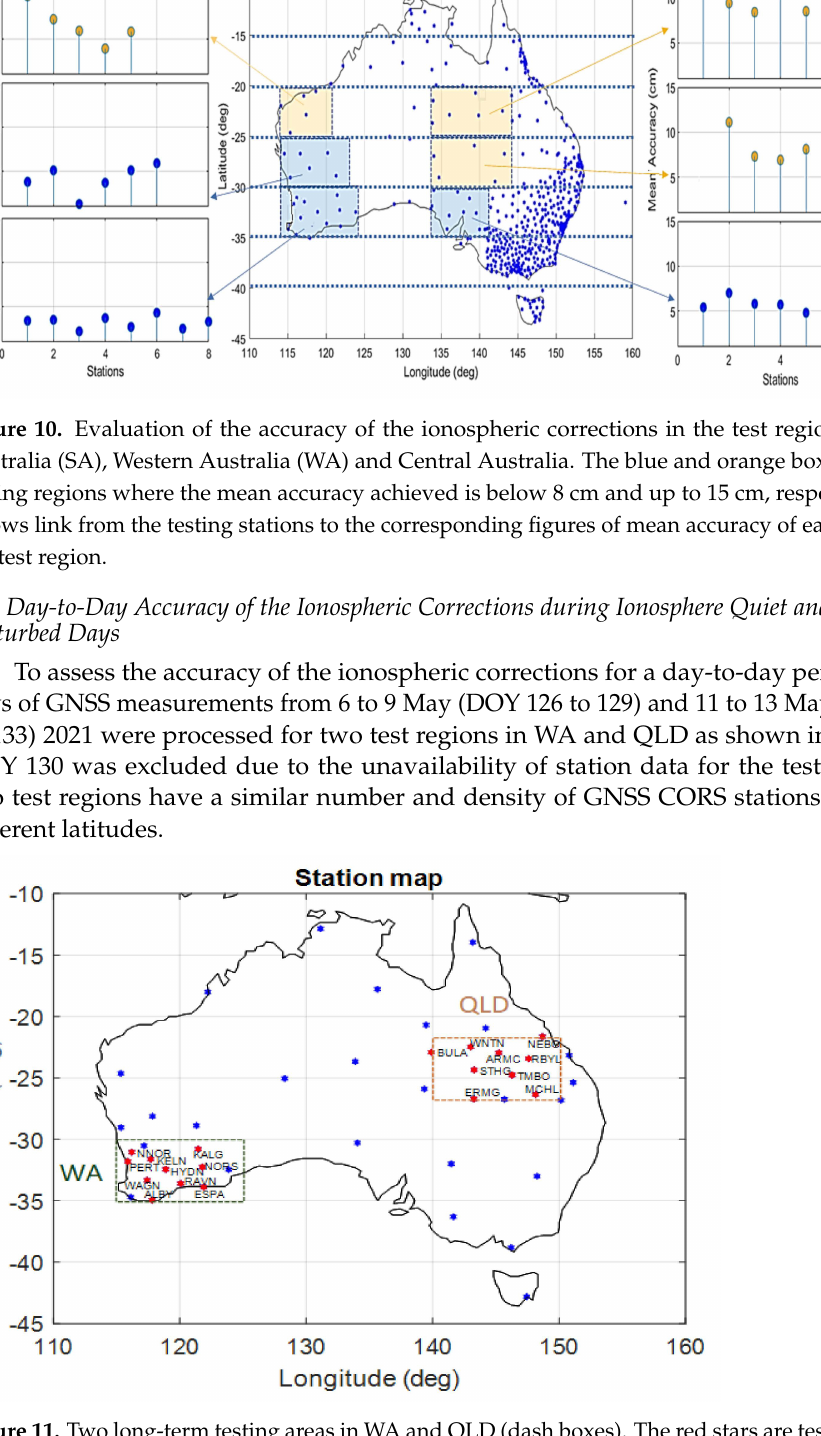
Figure 11. Two long-term testing areas in WA and QLD (dash boxes). The red stars are testing stations in each region. The blue stars are stations around Australia processed with PEA. Note that 15 stations around and inside the boxes were used for conducting interpolation at each testing